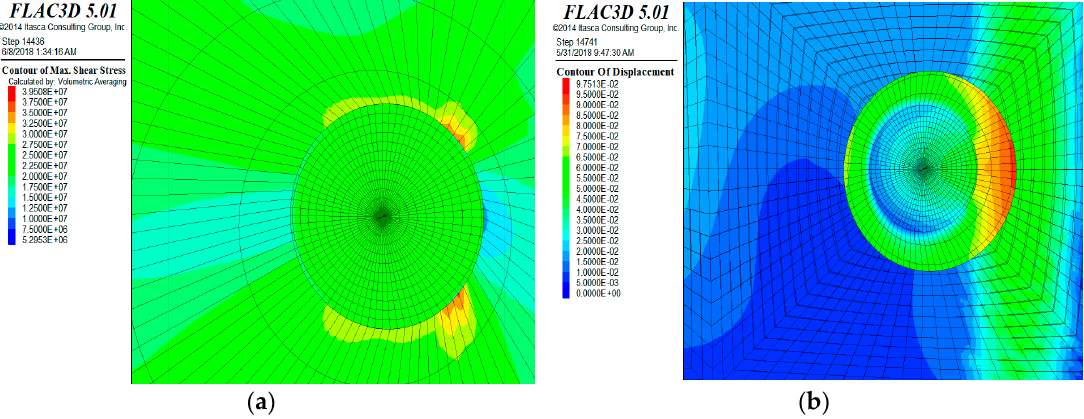
Figure 13. Contour of: ( a ) maximum shear stress after excavation and ( b ) displacement after excavation.